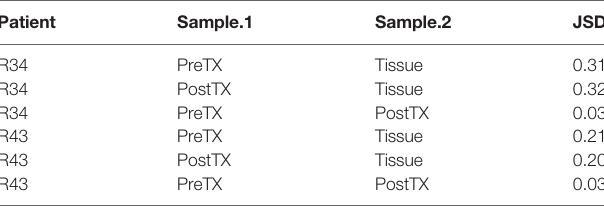
TABLE 2 | Jensen – Shannon divergence (JSD) of the overall TCR repertoire considering only the top 1,000 clones of the pre-transplant (PreTX) and post- transplant (PostTX) samples.